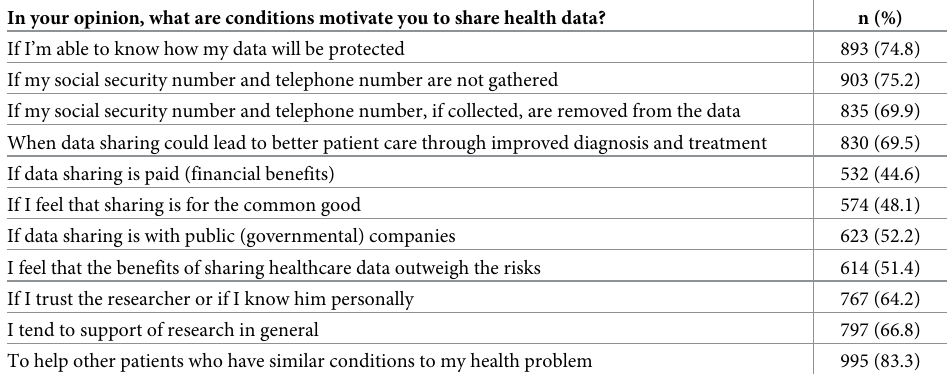
Table 2. Public perceptions towards medical data sharing motivators (n =